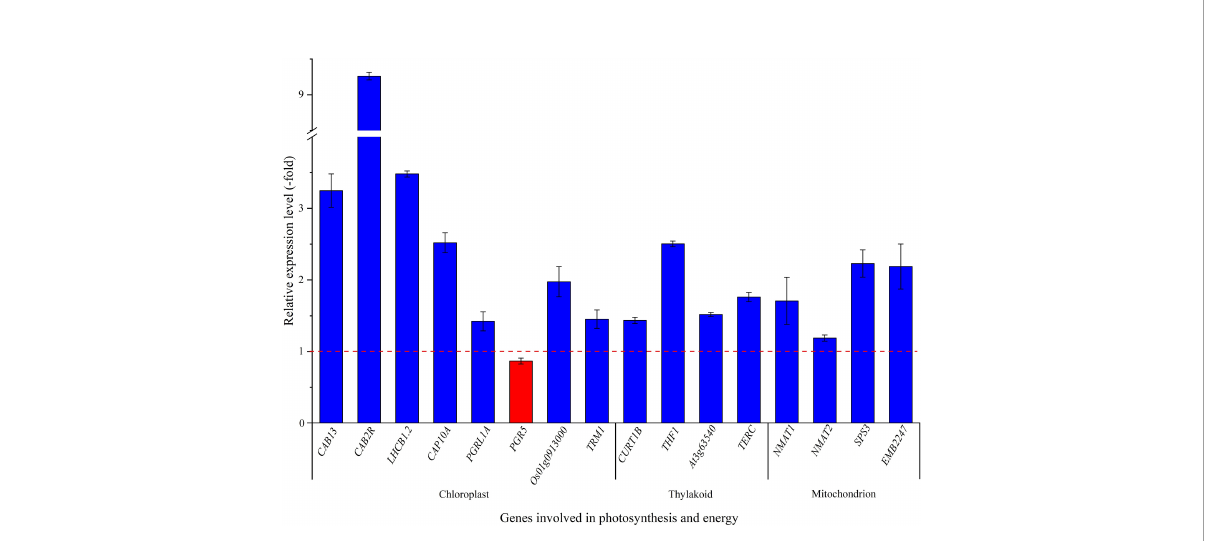
FIGURE 5 The expression level of genes involved in chloroplast, thylakoid and mitochondrion for seedlings grown at 15 versus 22°C, as determined by qRT-PCR (n=3). Column highlighted in blue represents gene up-regulation and red represents gene down-regulation. The red dotted line in the image differentiates up-regulation (>1) and down-regulation (<1) at 15°C compared with 22°C (Control),